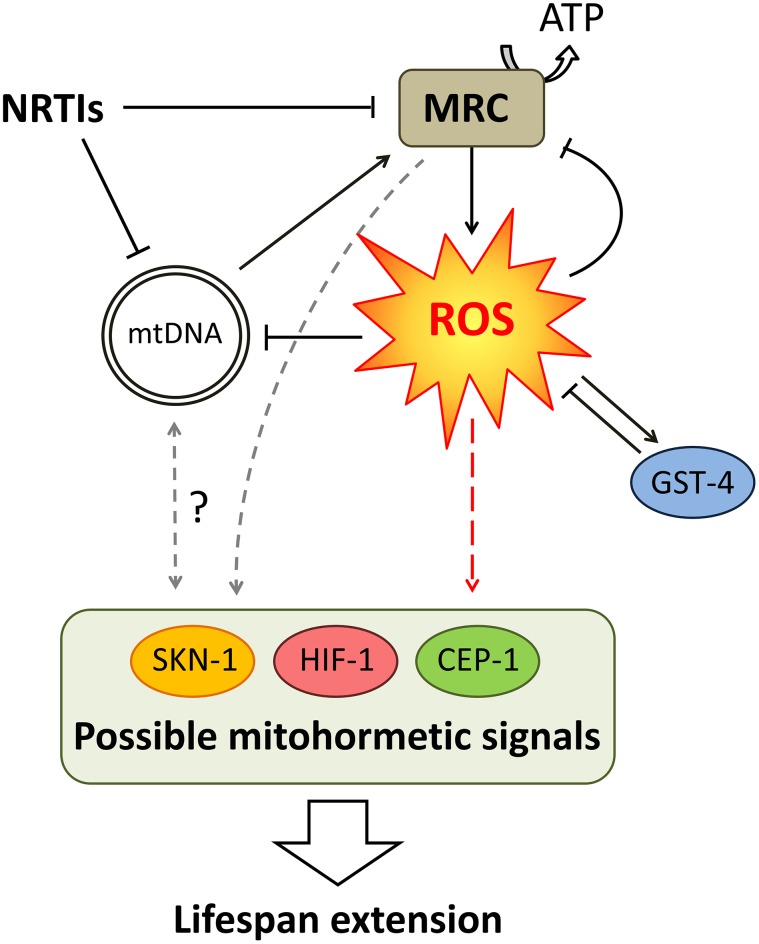
Schematic representation of short-term NRTI induced events which lead to longevity in C. elegans.NRTIs directly inhibit the mitochondrial respiratory chain (MRC) inducing an increase in reactive oxygen species (ROS). NRTIs also inhibit mtDNA replication which can, in time, disrupt MRC function through a depletion of mtDNA encoded transcripts and MRC complex components. Augmented ROS production likely induces mitohormetic signalling which involves factors involved in prolonged longevity signalling culminating in increased lifespan (red dashed arrow). Based on our results, likely signalling pathway include CEP-1, SKN-1 and HIF-1. NRTI induced ROS also prompts gst-4 expression. Black solid arrows indicate results from this study. Grey dashed arrows indicate hypothetical pathways.